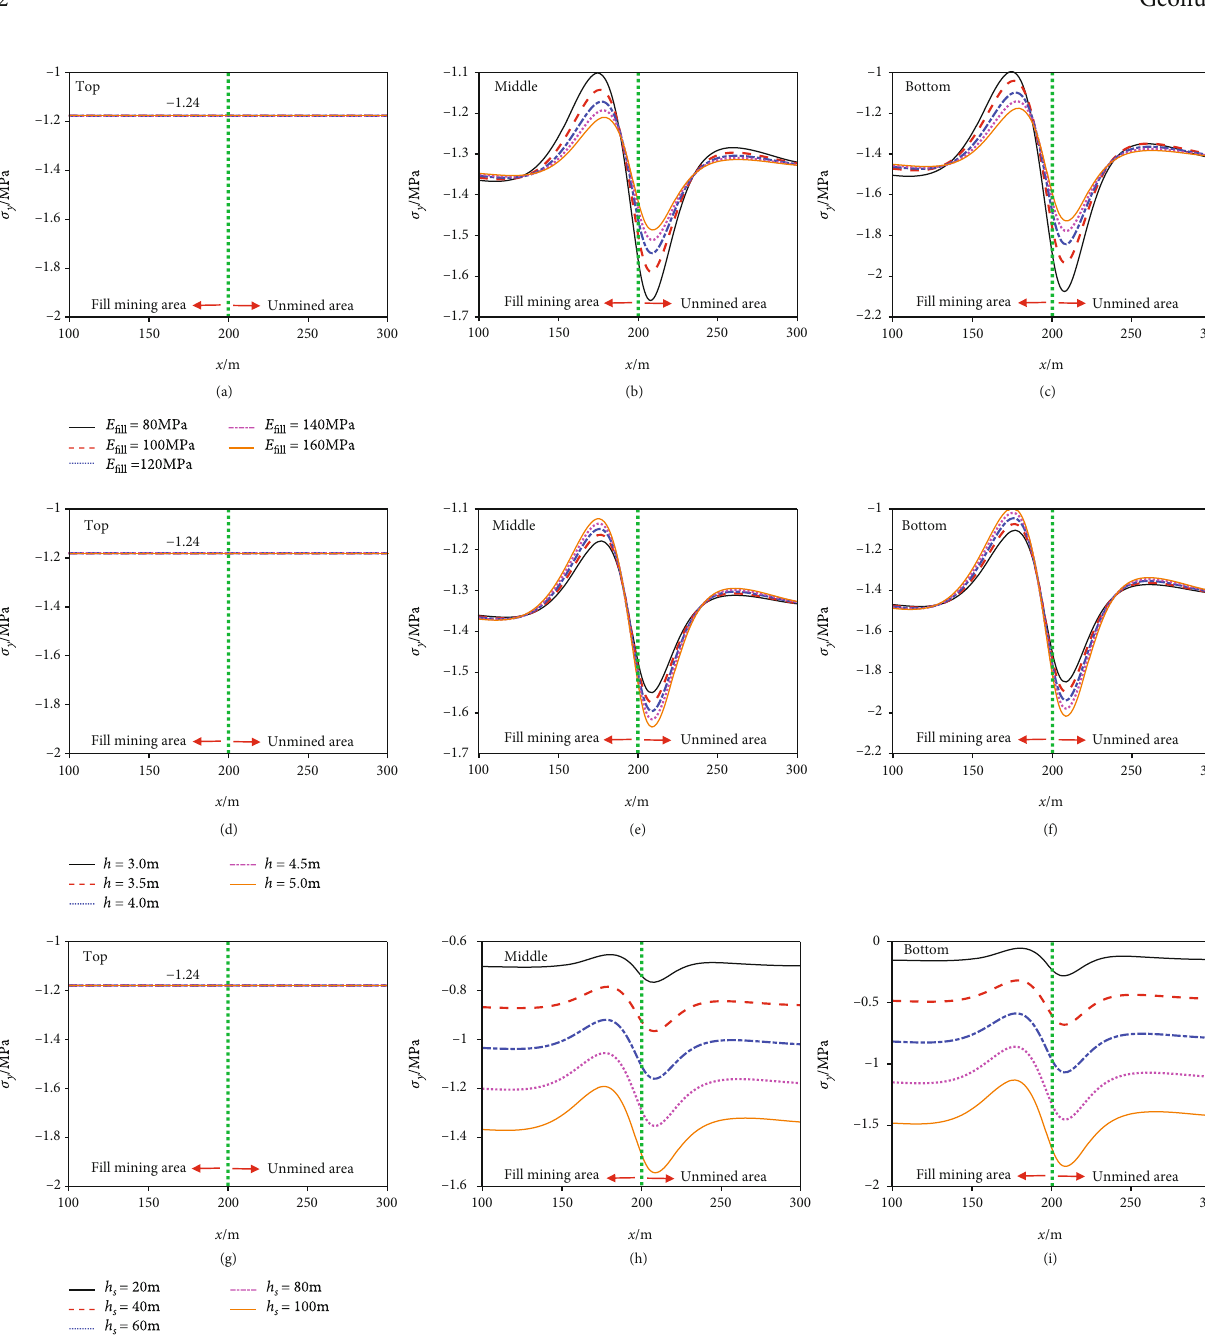
, (d – f) h , and (g – i) h fill s